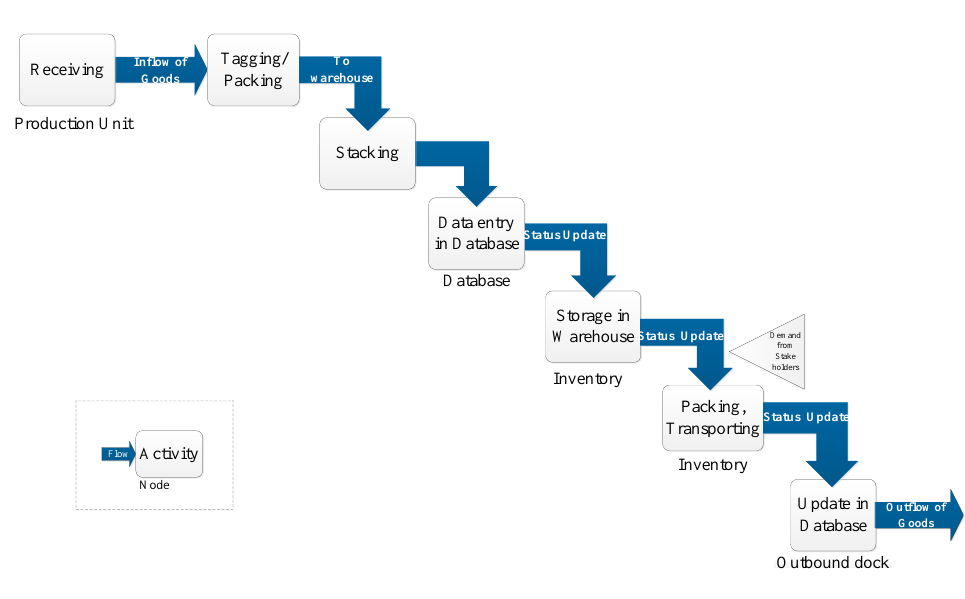
Figure 4. Operational view.